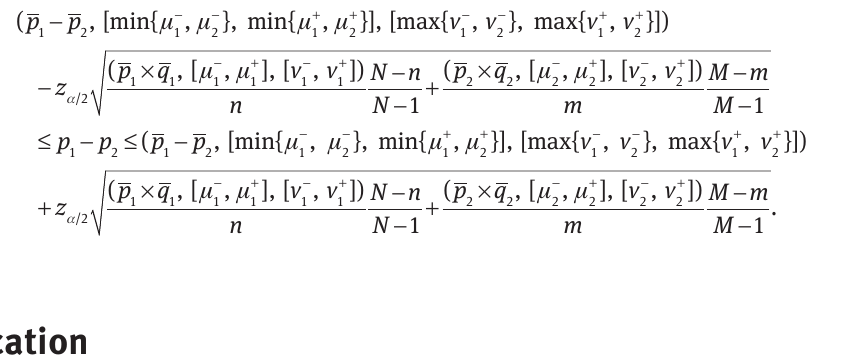
IVIF numbers have been used for the failure proportions of the radiators. Table 3 for infinite populations and Table 4 for finite populations present the numbers of the failed radiators within the warranty period. When the populations are infinite, the IVIF confidence interval is obtained as follows: